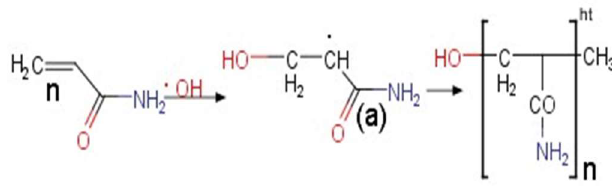
Figure 4. ( A ) DPV of the chemosensor in the presence of ACR. The ACR concentration (a-i) was used as follows: (a) Control (b) 1 × 10 −8 M, (c) 1 × 10 −6 M, (d) 1 × 10 −5 M, (e) 1 × 10 −4 M, (f) 1 × 10 −3 M; ( B ) The calibration curve of standard ACR with R 2 = 0.993. ( C ) A representative SEM micrograph of the chemosensor surface after its exposure to ACR with an estimated surface roughness of 0.24 μm.